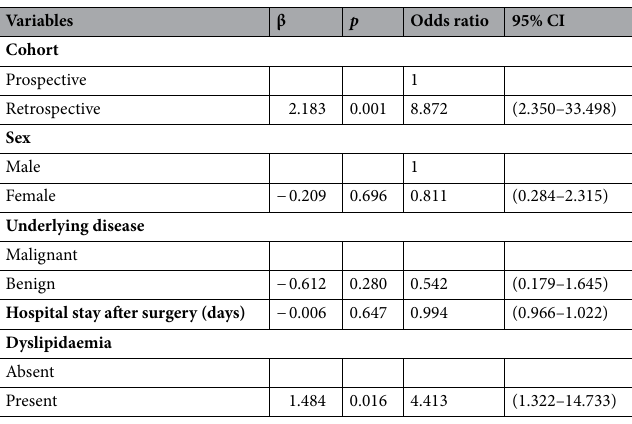
Table 2. Multivariate analysis.